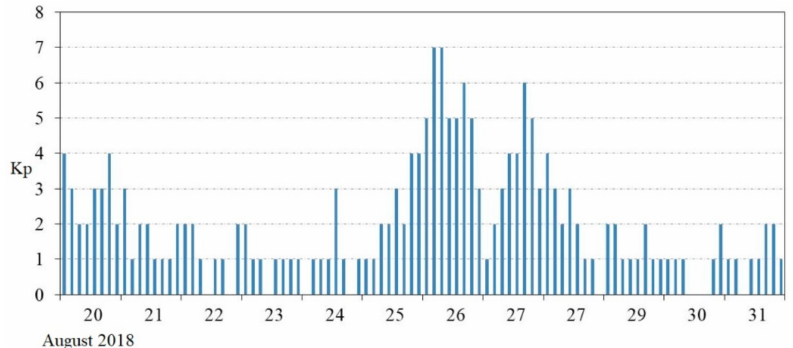
Figure 2. Variations in the Kp index from the middle to the end of August